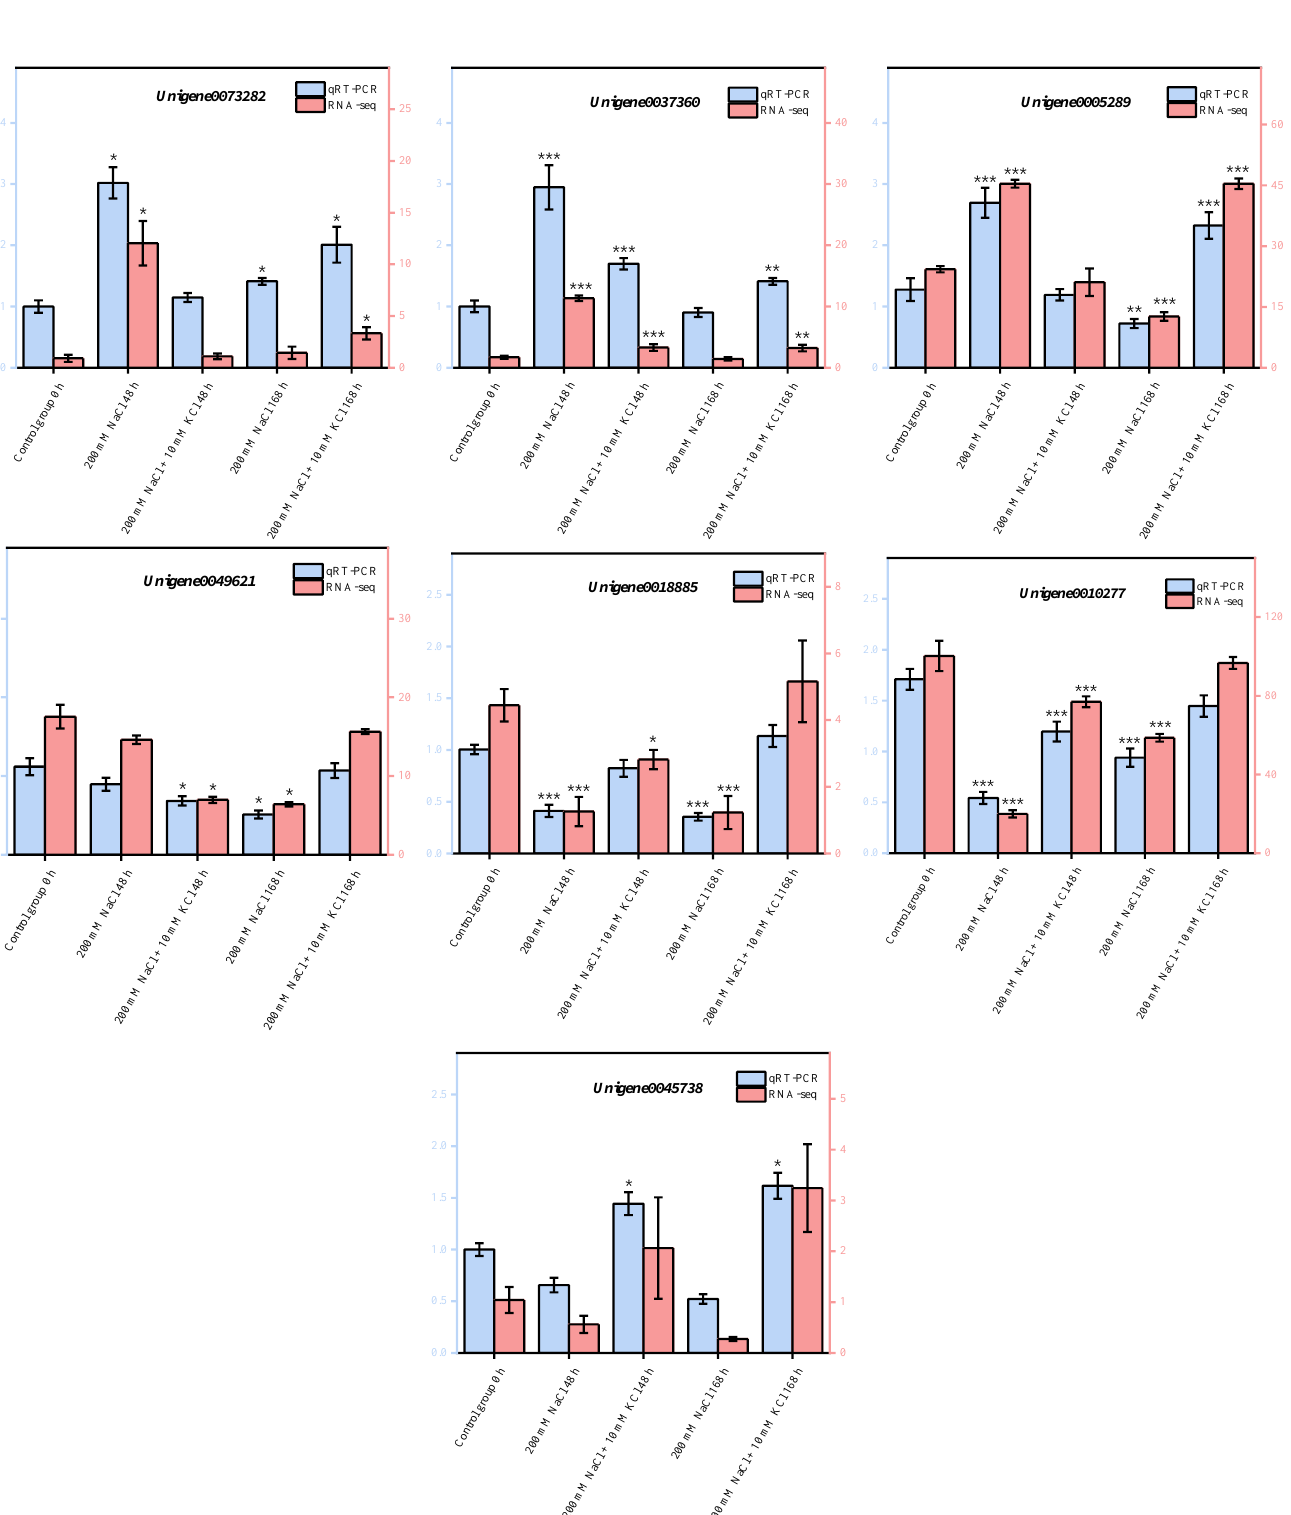
Figure 5. Validation of DEGs by qRT-PCR. (7 DEGs were randomly selected for qRT-PCR validation, and the error bars were obtained from multiple replicates of qRT-PCR. Note: p ≥ 0.05 is not marked; 0.01 < p < 0.05 is marked as *; 0.001 < p < 0.01 is marked as **; p ≤ 0.001 is marked as ***; Blue color Numerical value has been shown on the left side of the Y axis; Red color: Numerical value has been shown on the right side of the Y axis).